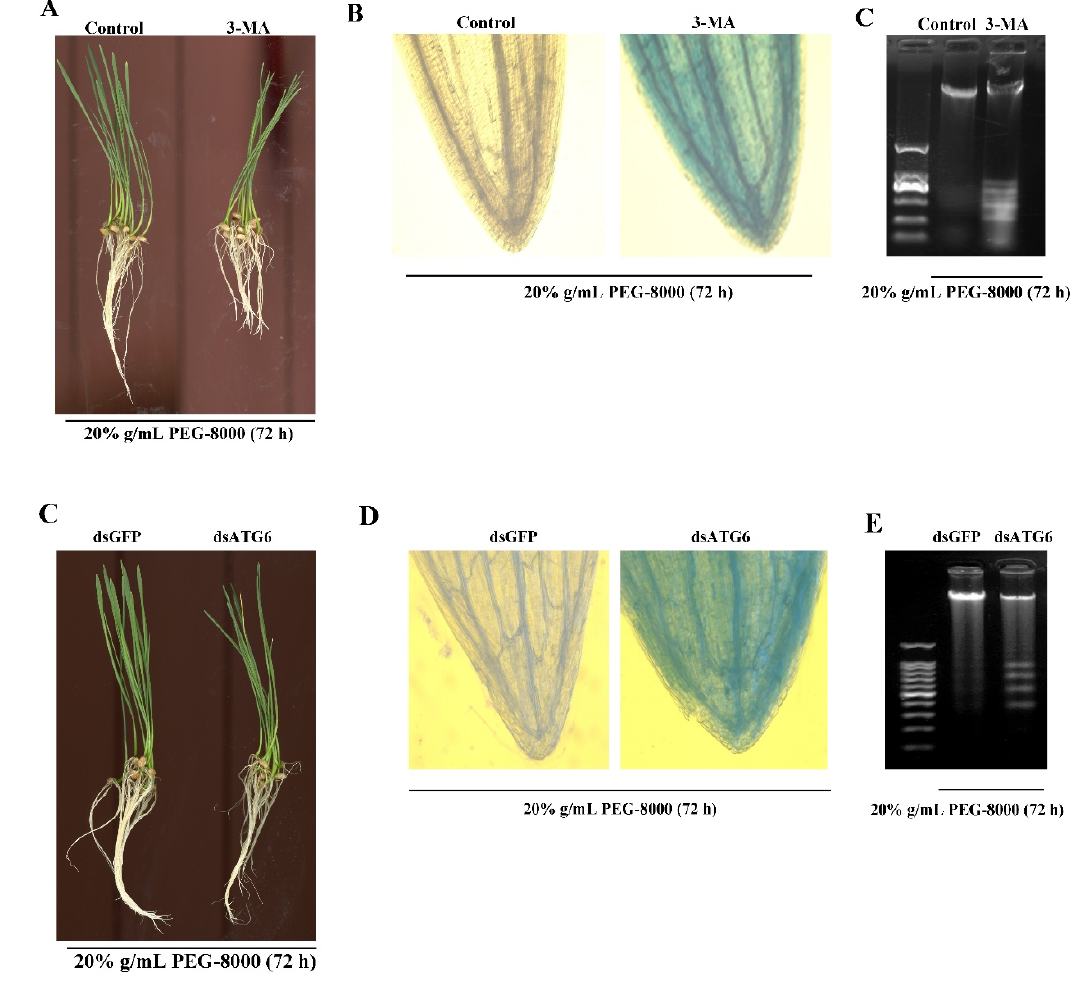
Figure 8. Acceleration of PEG-8000-induced PCD following inhibition of autophagy. ( A ) Seedling phenotypes following treatment with 3-MA in 20% PEG-8000 for 72 h. As a control, water instead of 3-MA was used. ( B ) Trypan blue staining of leaves following 3-MA treatment. ( C ) DNA ladder assay of PCD in the roots following 3-MA treatment. ( D ) Seedling phenotypes following ATG6 knockdown. dsGFP was used as a control. ( E ) Trypan blue staining of leaves following ATG6 knockdown. ( F ) DNA ladder assay of PCD in the roots following ATG6 knockdown. Data represent the results of three experiments.